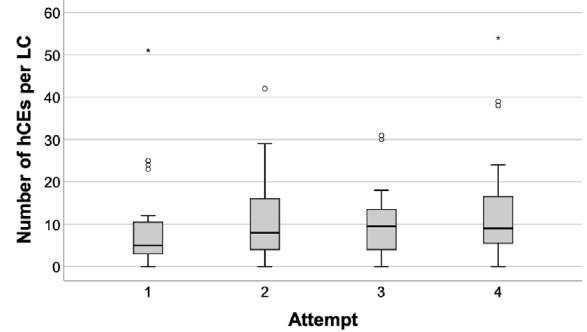
Figure 6. Number of hCEs per LC in the total population broken down into attempts 1 – 4, per box plot n = 24 subjects with one LC per attempt (total 96 LCs with 24 LCs per